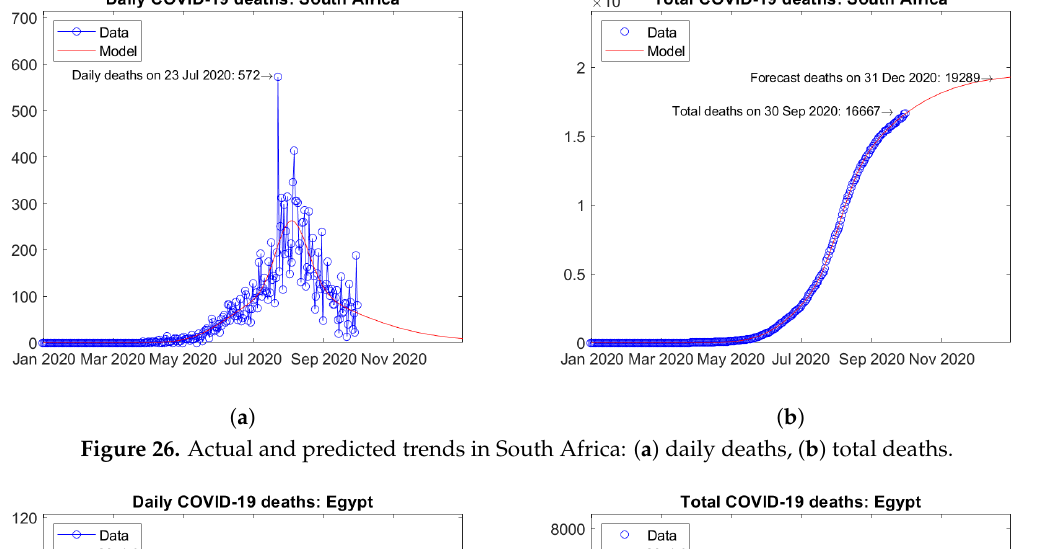
Figure 26. Actual and predicted trends in South Africa: ( a ) daily deaths, ( b ) total deaths.